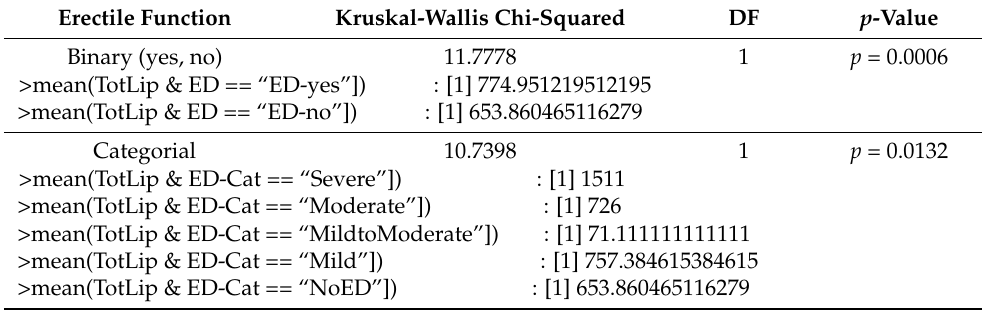
Table 5. Correlation between the level of total lipids and ED. Erectile Function